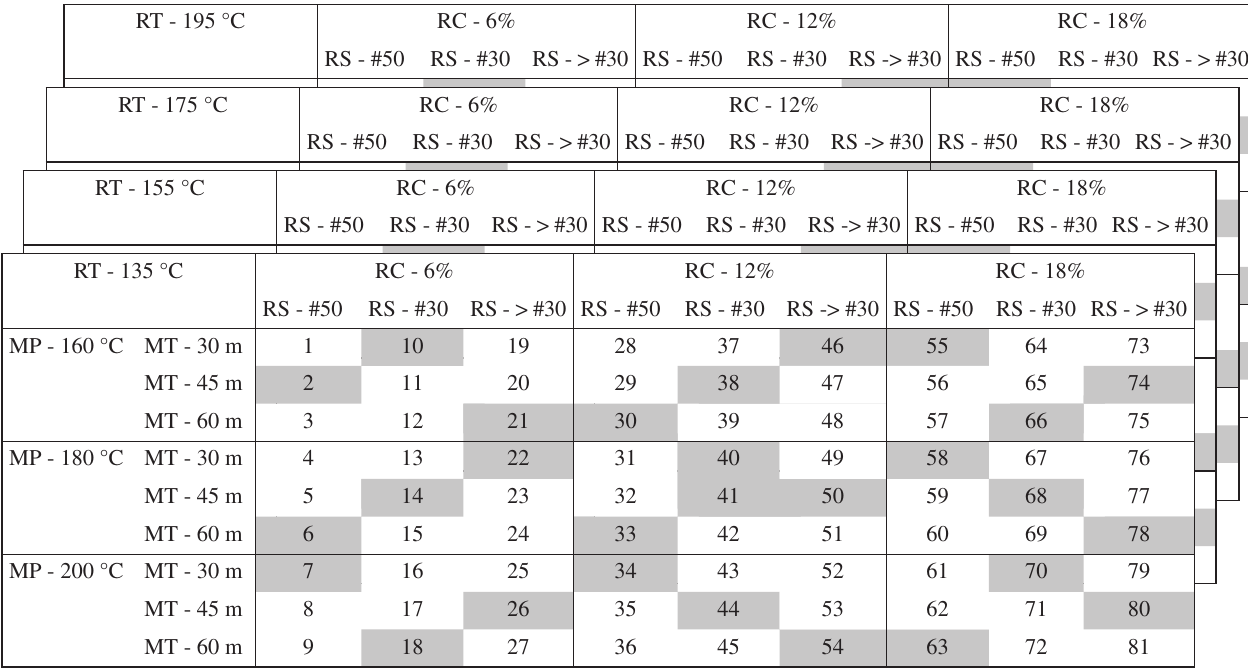
Table 2. Factorial